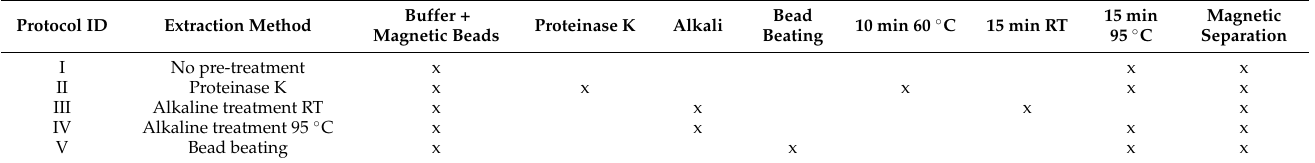
Table 1. Overview of working steps for different extraction